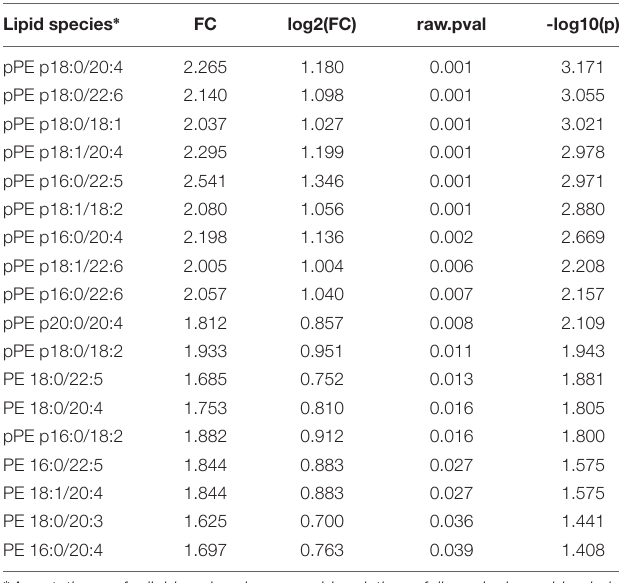
TABLE 2 | Lipid molecular species altered in serum of ZIKV versus control patients as revealed by volcano plot analysis. Lipid species ∗ FC log2(FC) raw.pval